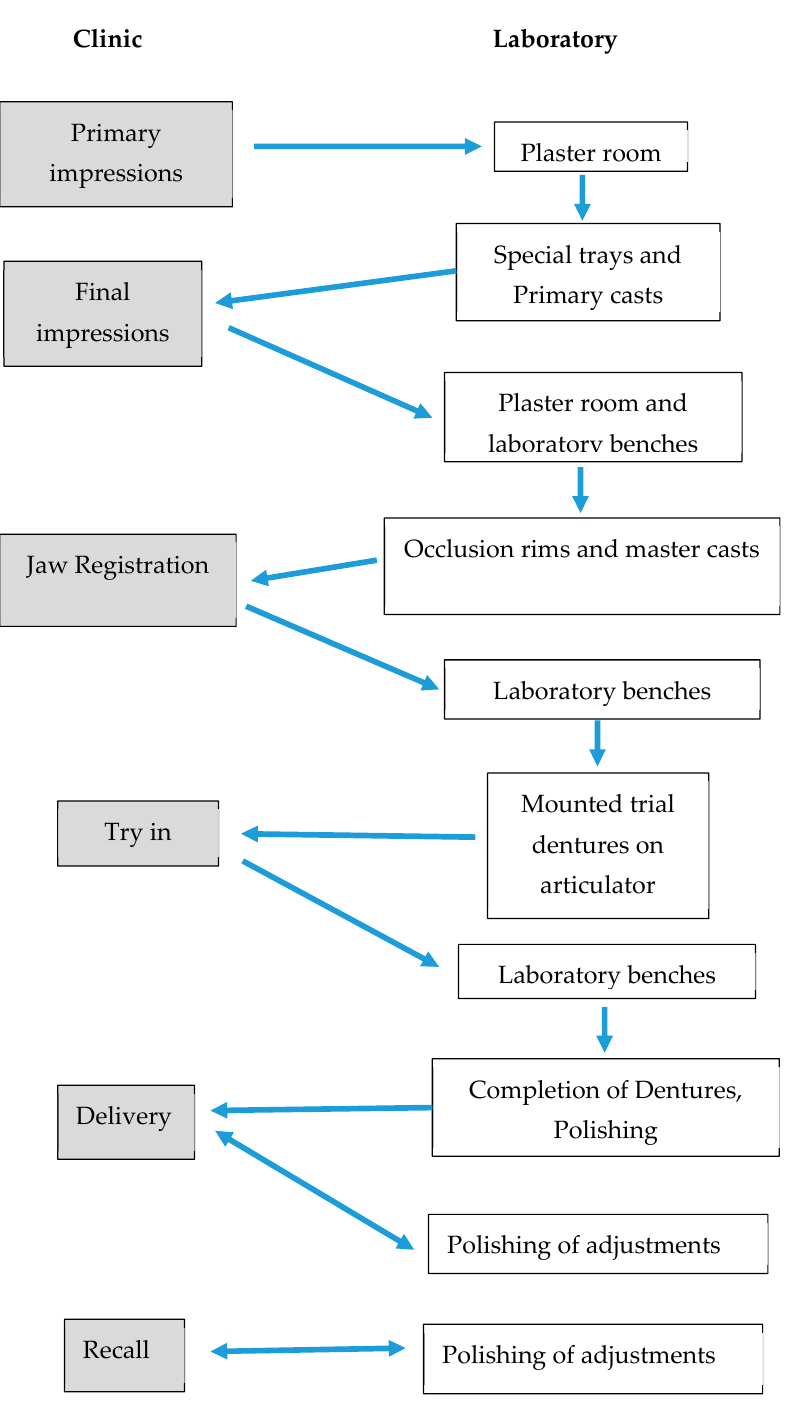
Figure 2. A flowchart representing the denture fabrication process.